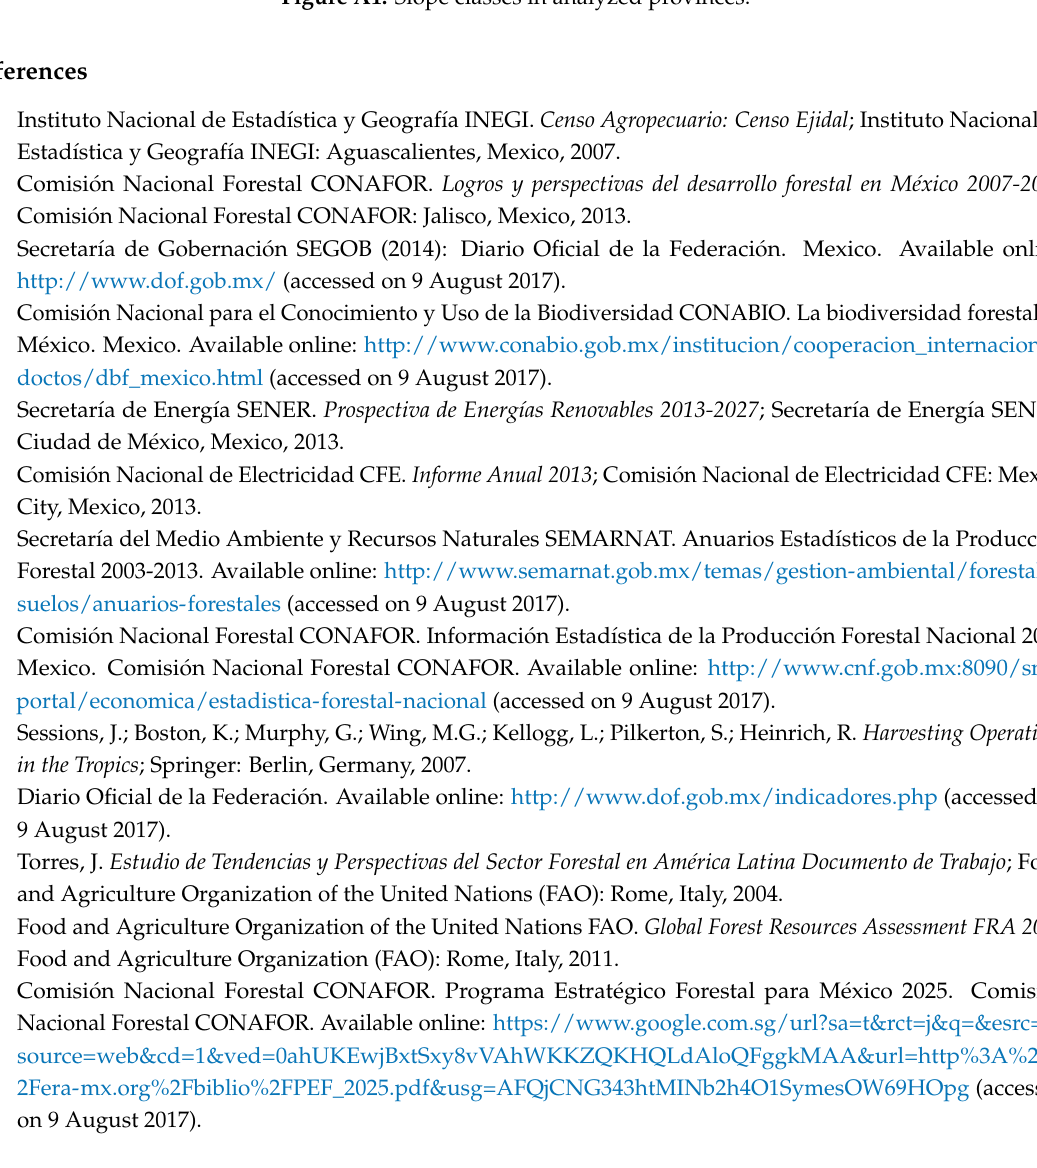
Figure A1. Slope classes in analyzed provinces.